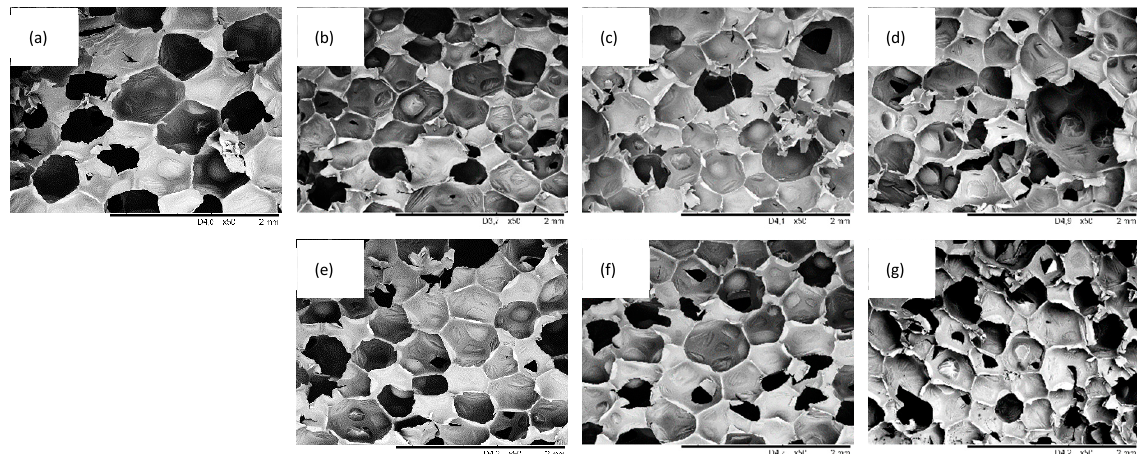
Figure 6. SEM images of ( a ) PUR-0, ( b ) PUR-SO-1, ( c ) PUR-SO-2, ( d ) PUR-SO-5, ( e ) PUR-SO/MTM-1, ( f ) PUR-SO/MMT-2, ( g ) PUR-SO/MMT-5.